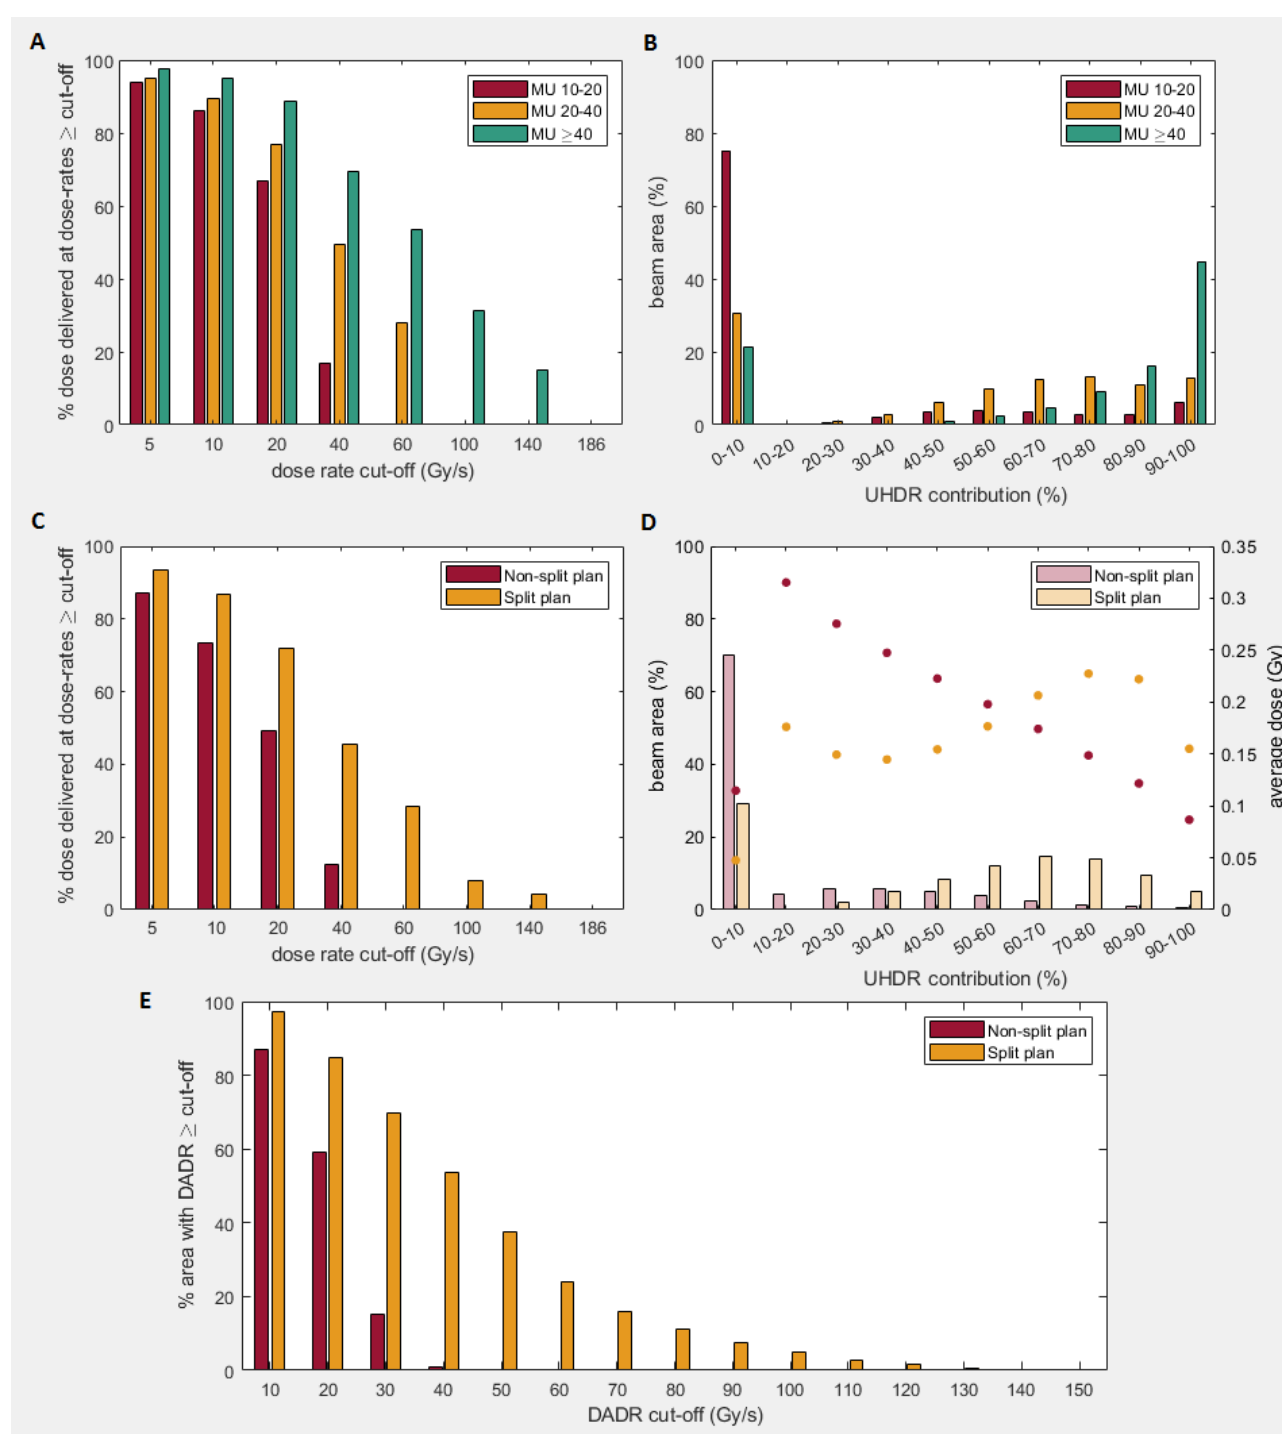
Figure 2. Average dose-rate distribution ( A,C ) and percentage ultra-high dose-rate (UHDR) contribution ( B,D ) for the subplans (upper) and the non-split/split plan (lower). In B, D, the UHDR-contribution (≥40 Gy/s) is shown vs. percentage beam area. D also gives the average dose for each UHDR-contribution interval. ( E ) gives dose-averaged dose-rate (DADR) distribution for non-split/split plans. The average DADR was 46/23 Gy/s for the split/non-split plans. Total dose threshold is 2 cGy.